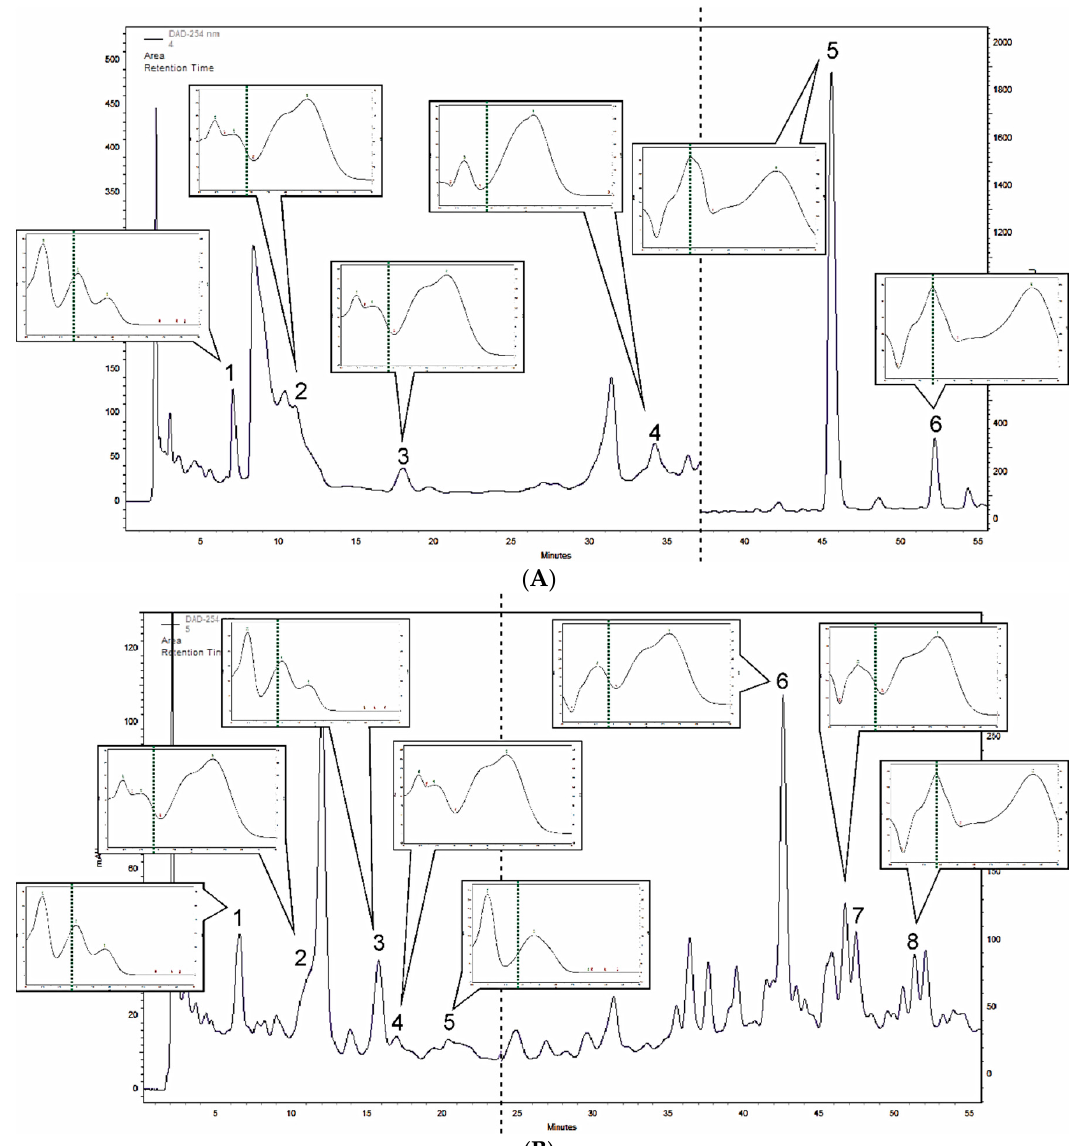
Figure 2. Examples of high ‐ performance liquid chromatography ‐ diode array detection ‐ based separation ( λ = 254 nm) of leaf extracts of ( A ) Ruta graveolens (1, protocatechuic acid; 2, chlorogenic acid; 3, caffeic acid; 4, p ‐ coumaric acid; 5, rutoside; 6, quercetin) and ( B ) Artemisia abrotanum (1, protocatechuic acid; 2, chlorogenic acid; 3, vanillic acid; 4, caffeic acid; 5, syringic acid; 6, isochlorogenic acid; 7, rosmarinic acid; 8, quercetin).